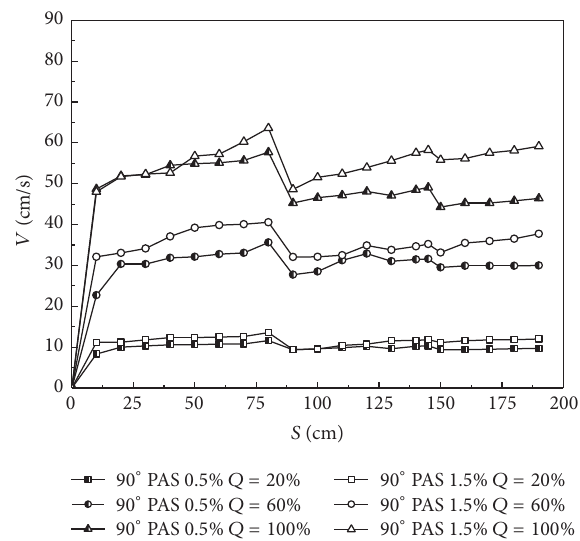
Figure 6: The PAS velocity-position diagram of various flow in 90 ∘ curved tube.